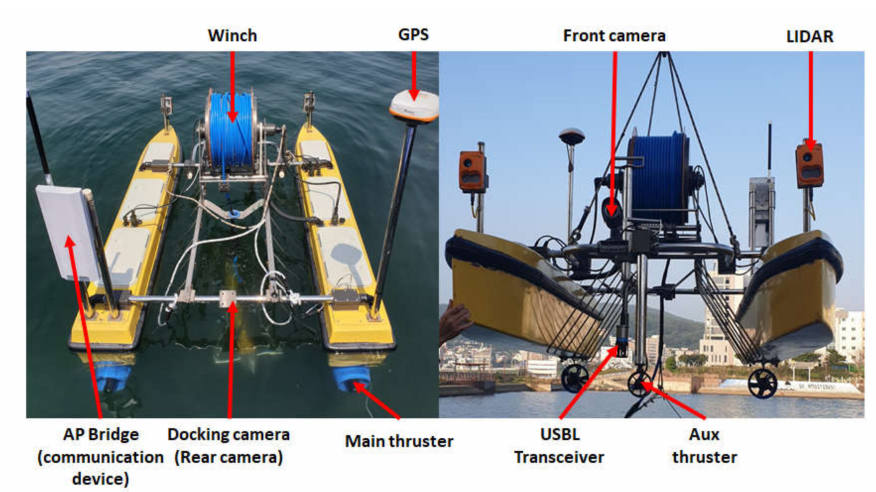
Figure 4. Assembled USV and component. GPS, global positioning system; USBL, ultrashort baseline.